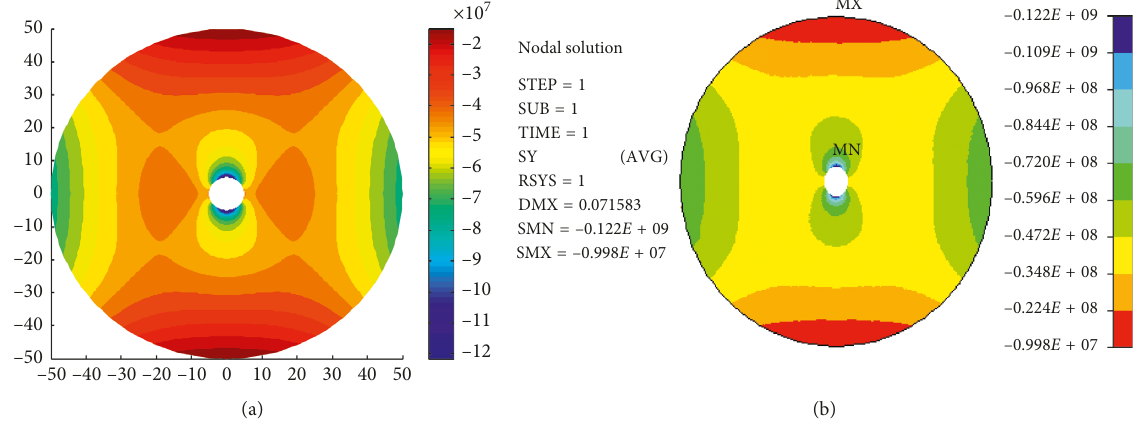
Figure 6: Cloud diagram of the circumferential stresses σ